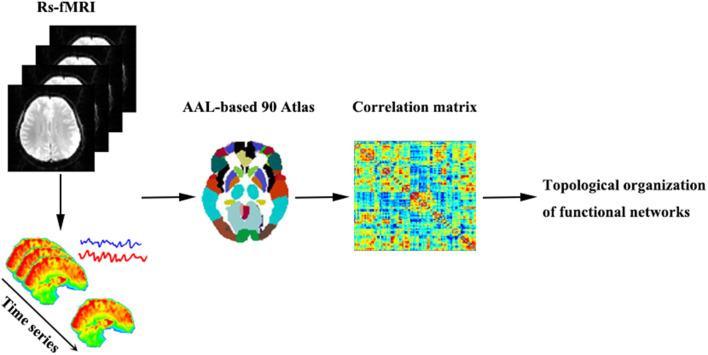
A brief flowchart showing the construction of the functional networks. Abbreviations: Rs-fMRI, resting-state functional magnetic resonance imaging; AAL, automated anatomic labeling.